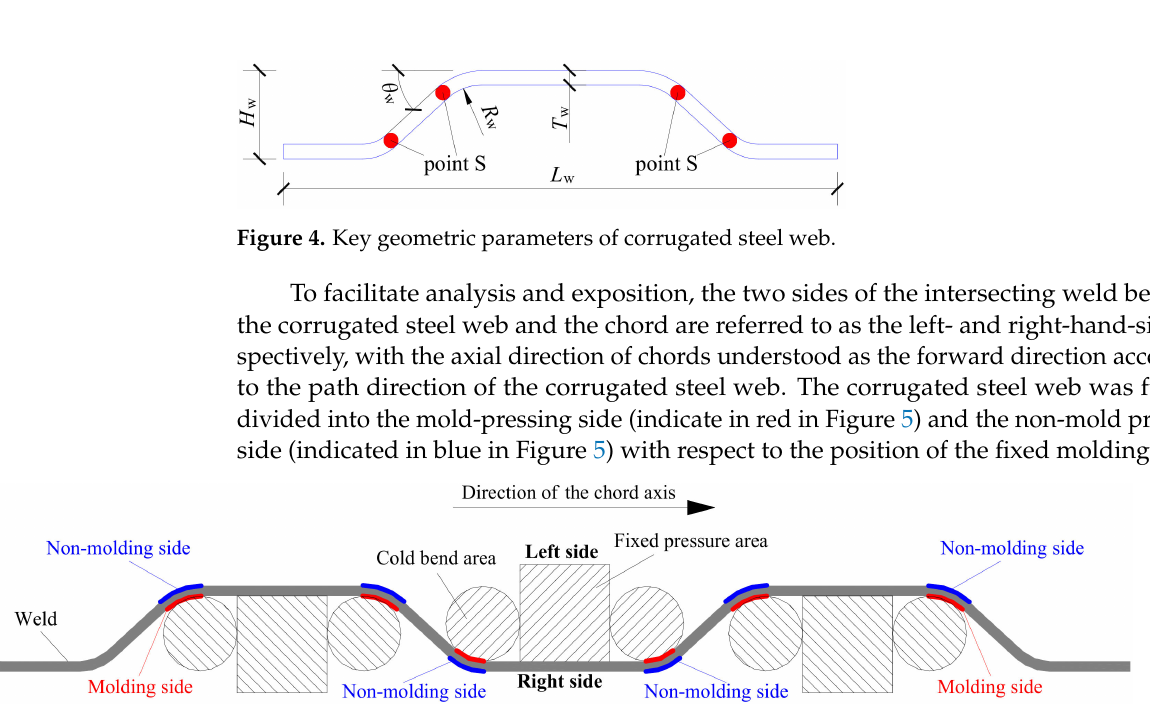
Figure 5. Locations of intersecting welds between corrugated steel web and chord.